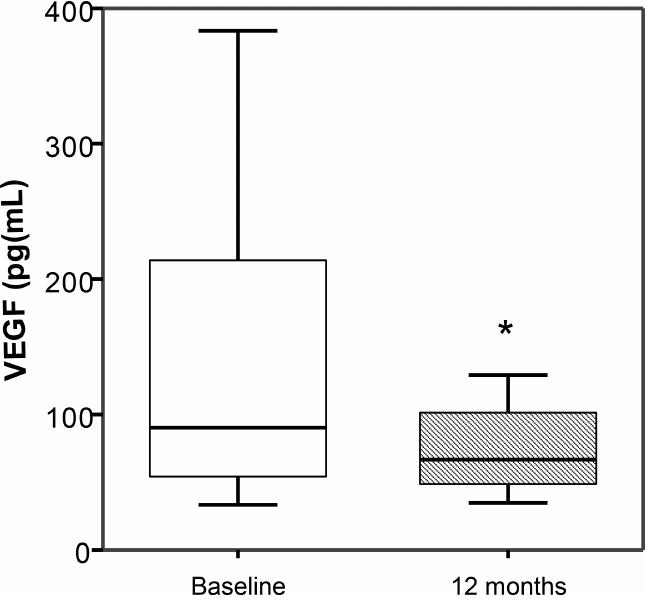
Fig 3. Plasma levels of VEGF in hypertensive patients before (baseline) and after treatment intensification during 12 months. Results are expressedas (pg/mL) of VEGF plasma levels. Data are visualizedas standard box plots. * P < 0.05vs before intensification of